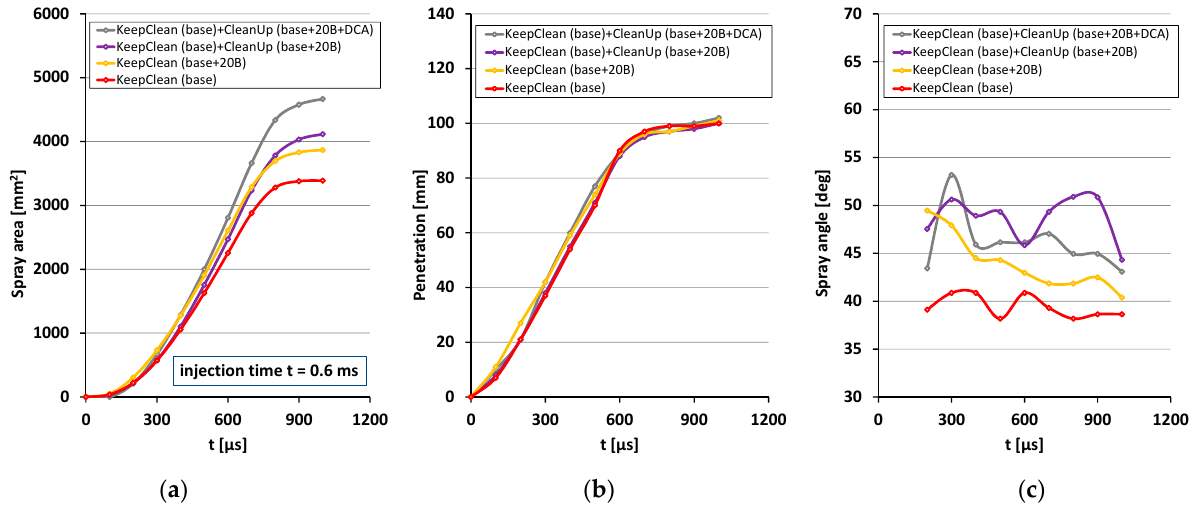
Figure 8. Analysis of geometric indices of the atomized fuel spray (six fuel jets were considered combined): ( a ) spray area; ( b ) penetration; and ( c ) jet cone angle.